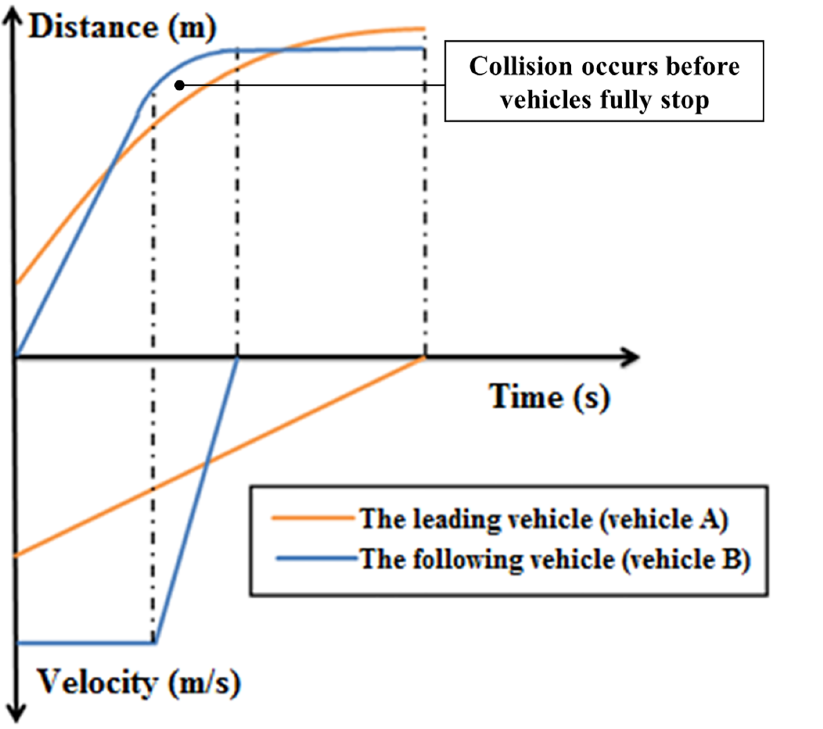
Fig 1. Vehicle collision distance-time-velocity